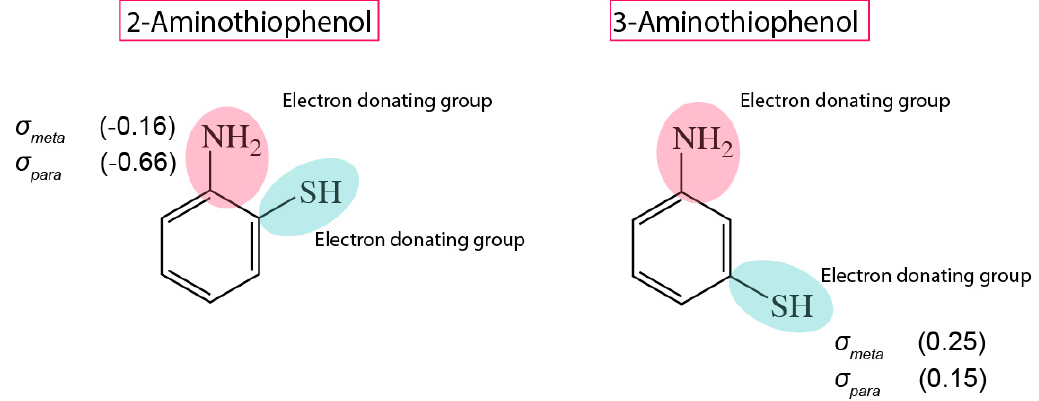
Figure 1. Chemical structure of 2-aminothiophenol and 3-aminothiophenol. The Hammett’s constants of the respective substituents are displayed beside the chemical